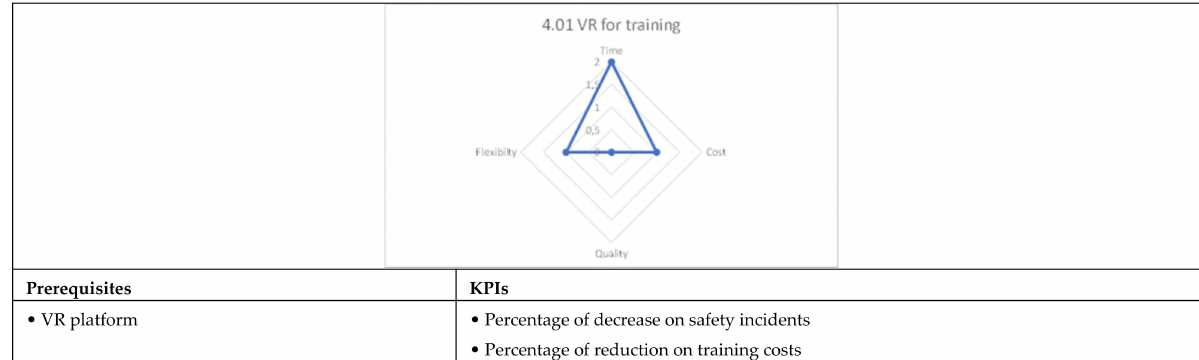
Figure A33. VR for training data sheet.